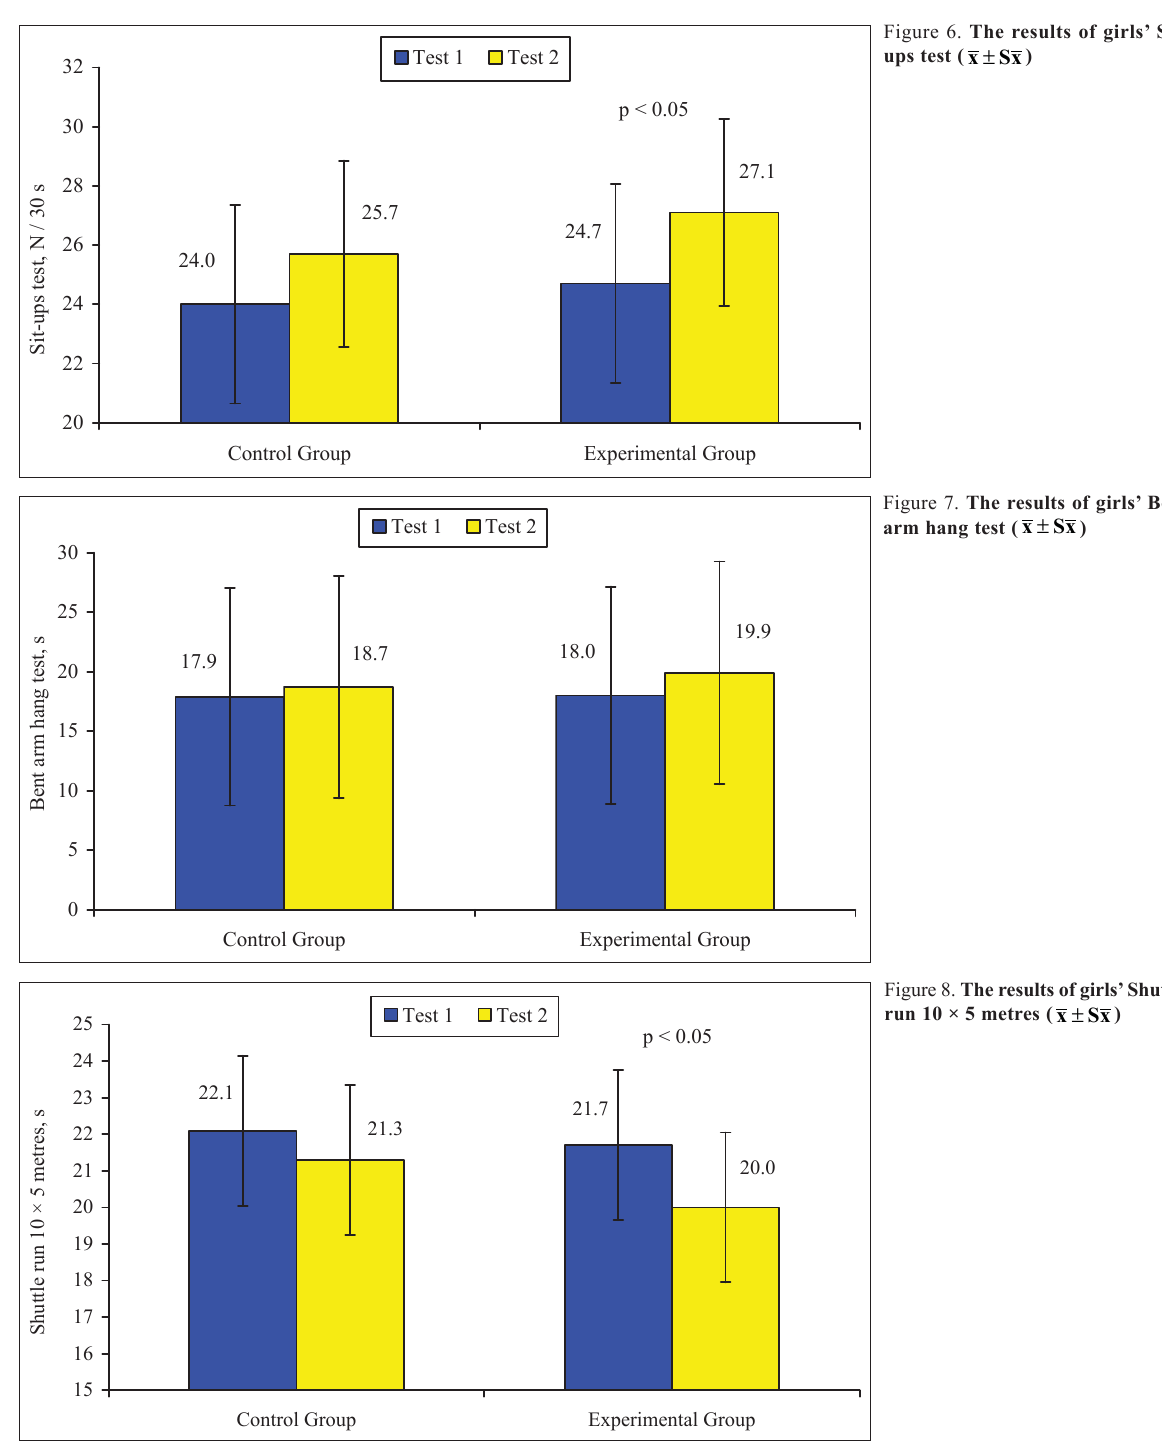
Figure 8. The results of girls’ Shuttle run 10 × 5 metres ( xSx